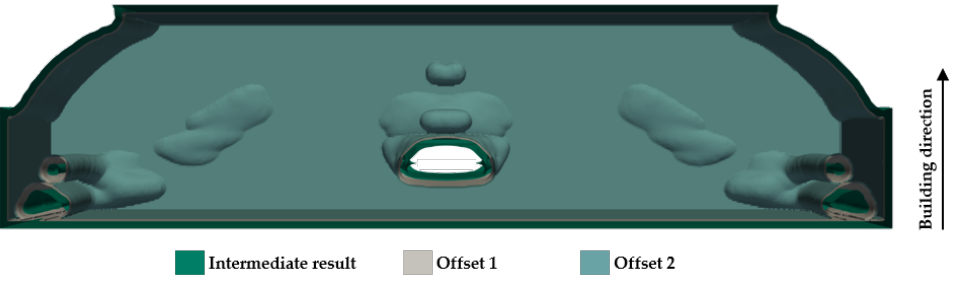
Figure 6. Surface meshes of the intermediate result, offset 1 and offset